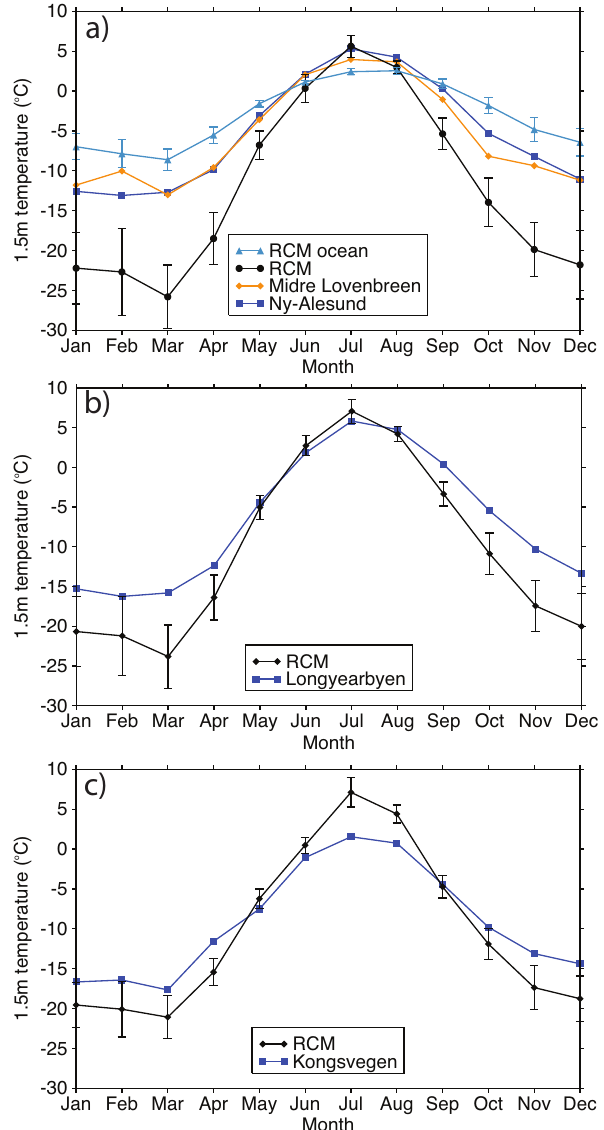
Fig. 3. Modelled and observed mean monthly surface air tem- perature for, the grid cell containing (a) Ny- ˚Alesund and Midtre Lov´enbreen, (b) Longyearbyen and (c) Kongsvegen. In addition, temperature from the grid cell from the nearest ocean grid cell to Ny- ˚Alesund is plotted in (a) for comparison with the land cell. Each of the RCM mean monthly values have whiskers representing ± σ